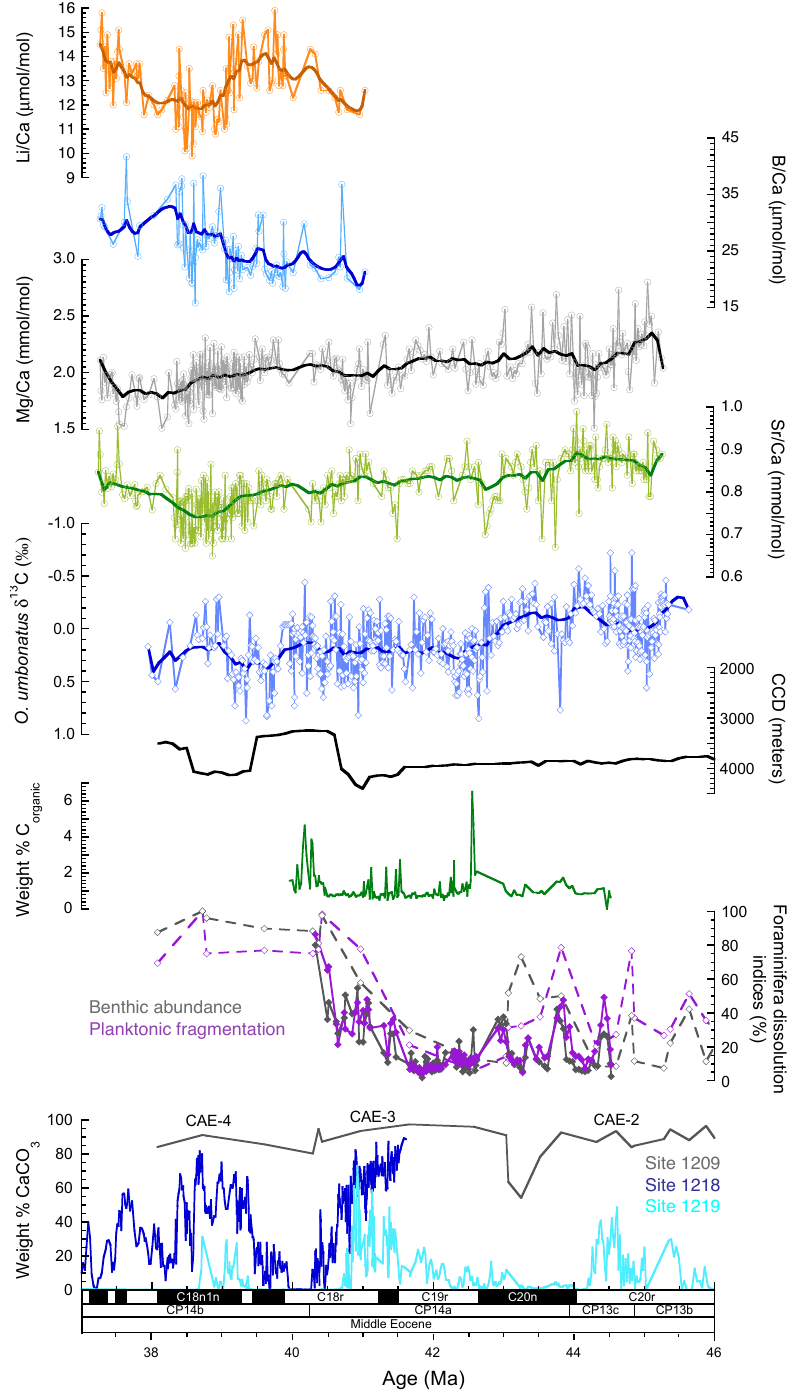
Fig. 1. Comparison of high-resolution middle Eocene records of O. umbonatus Li/Ca, B/Ca, Mg/Ca and Sr/Ca from ODP Site 1209, equatorial Pacific Ocean with other carbonate system proxies. Heavier lines on X/Ca records denote a weighted smoothing function. Benthic abundance (%) and planktonic fragmentation, proxies for carbonate dissolution, are shown in grey and pink respectively; solid lines denote data from this study, and dashed lines are data from Hancock and Dickens (2005). Differences in absolute values reflect the different size fractions used to define the “coarse” fraction. The records of weight percentage of CaCO 3 are from Hancock and Dickens (2005), Tripati et al. (2005) and Lyle et al. (2005). CAE is an abbreviation for the carbonate-accumulation events documented by Lyle et al. (2005). The calcite compensation depth (CCD) reconstruction for the Pacific Basin is from Tripati et al.